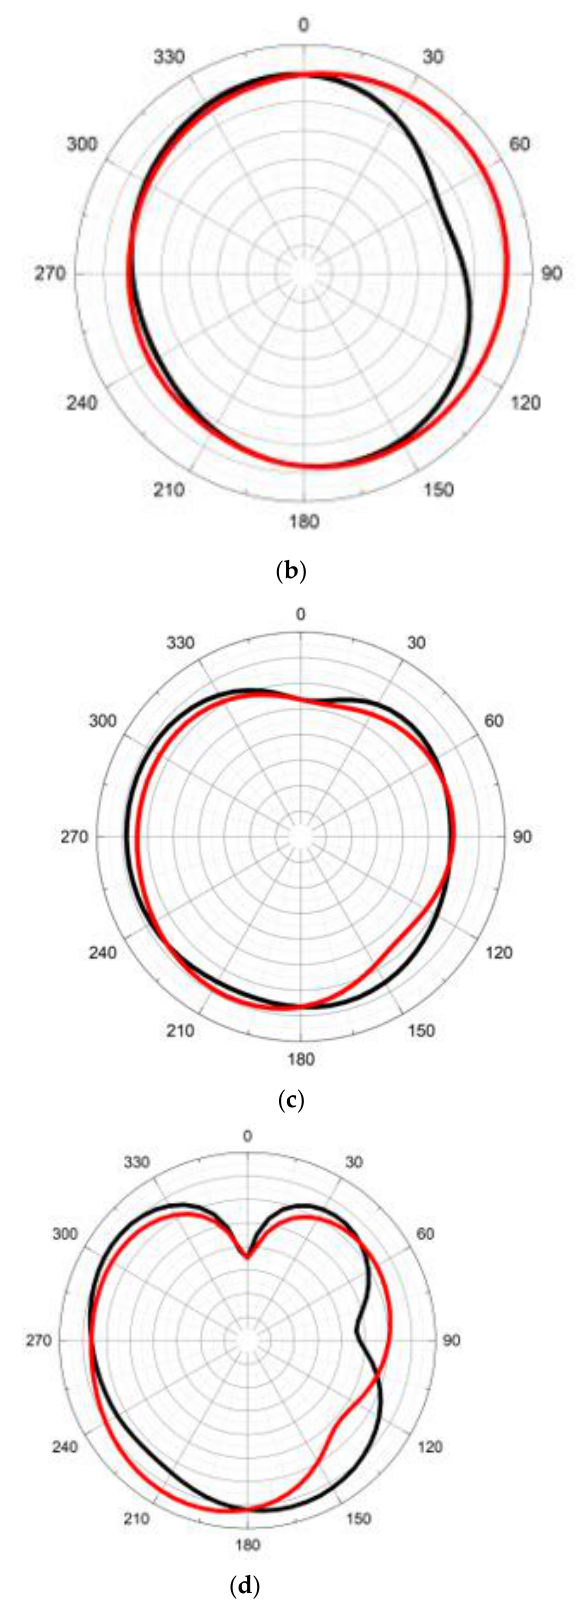
Figure 36. Radiation Pattern at ( a ) 4.35 GHz, ( b ) 5.9 GHz, ( c ) 8.7 GHz, ( d ) 9.7 GHz.